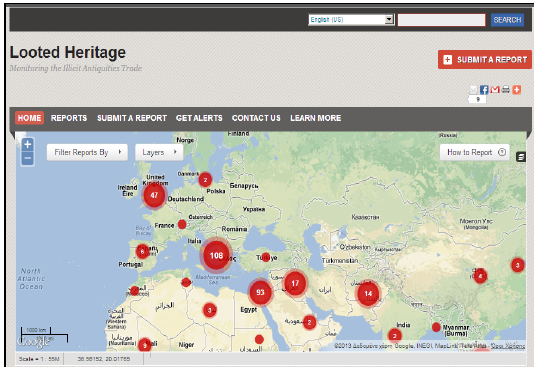
Figure 9: WikiLoot [https://heritage.crowdmap.com/] (D) Use the information to create 3D Web GIS.